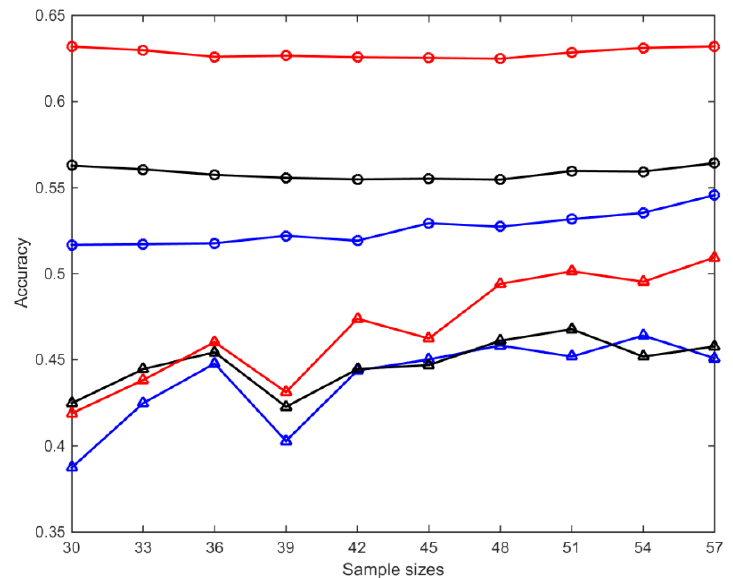
Figure 12. The average test scores (triangle) and repeated 10-fold CV scores (circle) for N pre s of 5–35 and C thrd of 0.8 dependent on sample sizes for the schemes single-MLR (blue), F-ratio (black), and L1 (red).